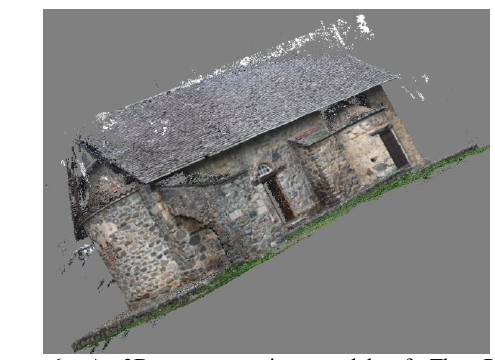
Figure 6: A 3D reconstruction model of The Panayia Phorviotissa or Asinou church.